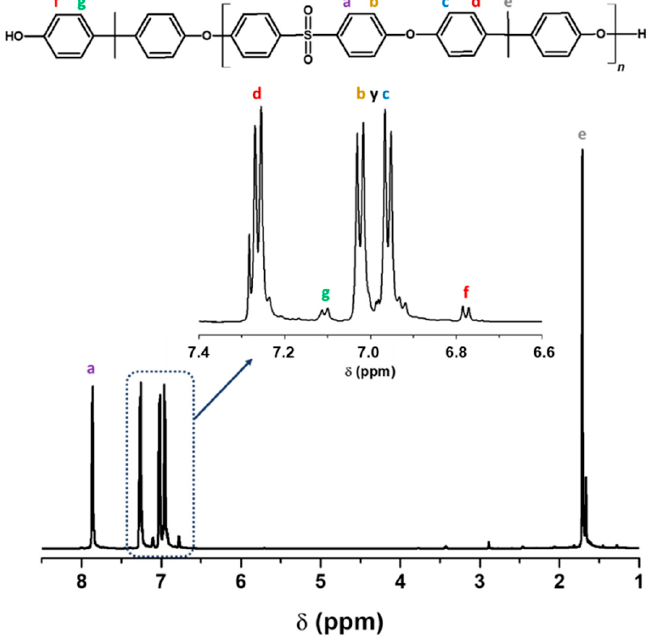
Figure 1. Infrared spectrum of PEES of high (HMW-PEES) and low (LMW-PEES) molecular weight.